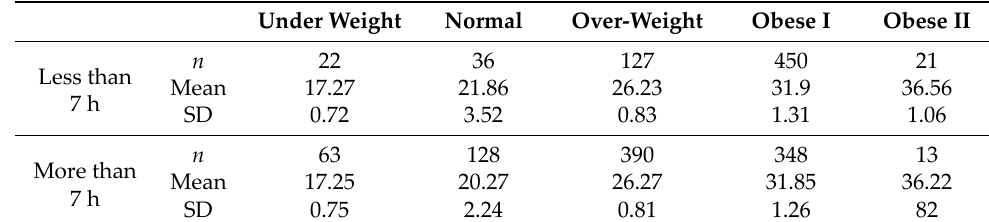
Table 7. Differences in BMI according to sleep patterns. Under Weight